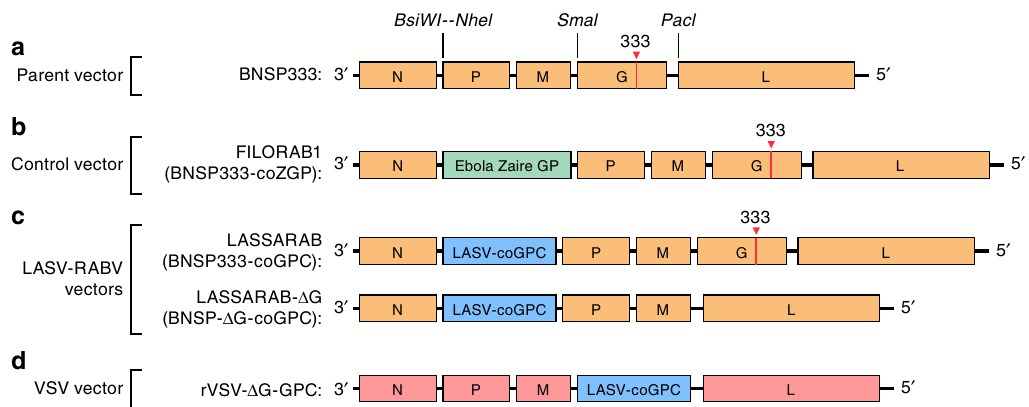
Fig. 1 Diagram of vaccine constructs and controls. BNSP333 is the parental vector and FILORAB1, the control used, is based on BNSP333 with a codon- optimized Zaire Ebola Virus Glycoprotein (EBOV GP) inserted between N and P through the BsiWI and NheI restriction digest sites. LASSARAB was generated in a similar manner as FILORAB1, from BNSP333 by cloning a codon-optimized version of Lassa virus glycoprotein (LASV GPC) in the BsiWI and NheI restriction digest sites. LASSARAB- Δ G was further generated from LASSARAB by removing the native rabies glycoprotein (G) by using the restriction digest sites SmaI and PacI. rVSV-GPC was generated by replacing the native VSV glycoprotein (G) by LASV GPC at the same sites. rVSV-GPC was created to be used as a control vector and as a scaffold to produce a native LASV GPC antigen for ELISAs (see Methods